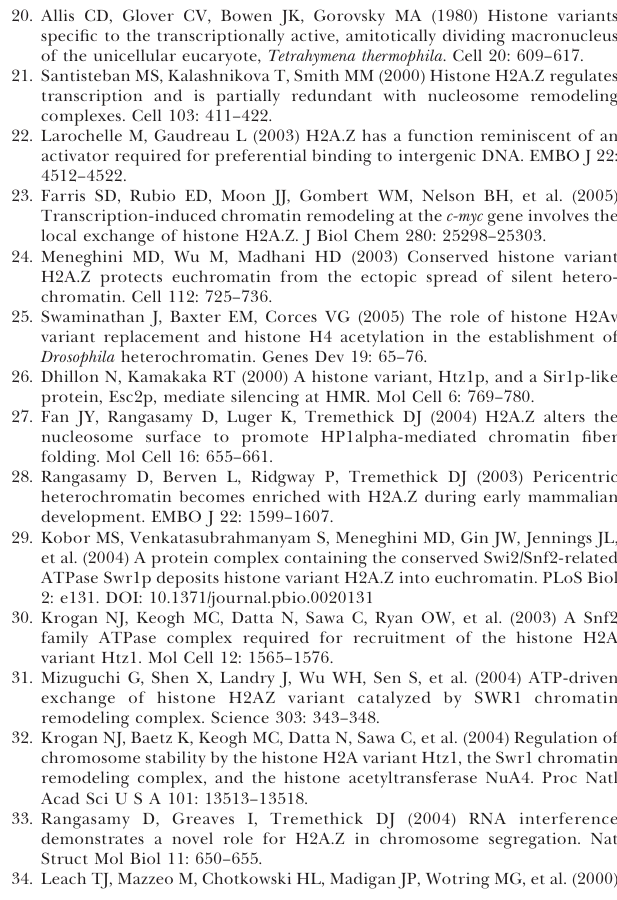
Table S8. Sequences of the Oligonucleotides Used in the LM-PCR Assay to Map Nucleosomes within the GAL1 Promoter Found at DOI: 10.1371/journal.pbio.0030384.st008 (18 KB